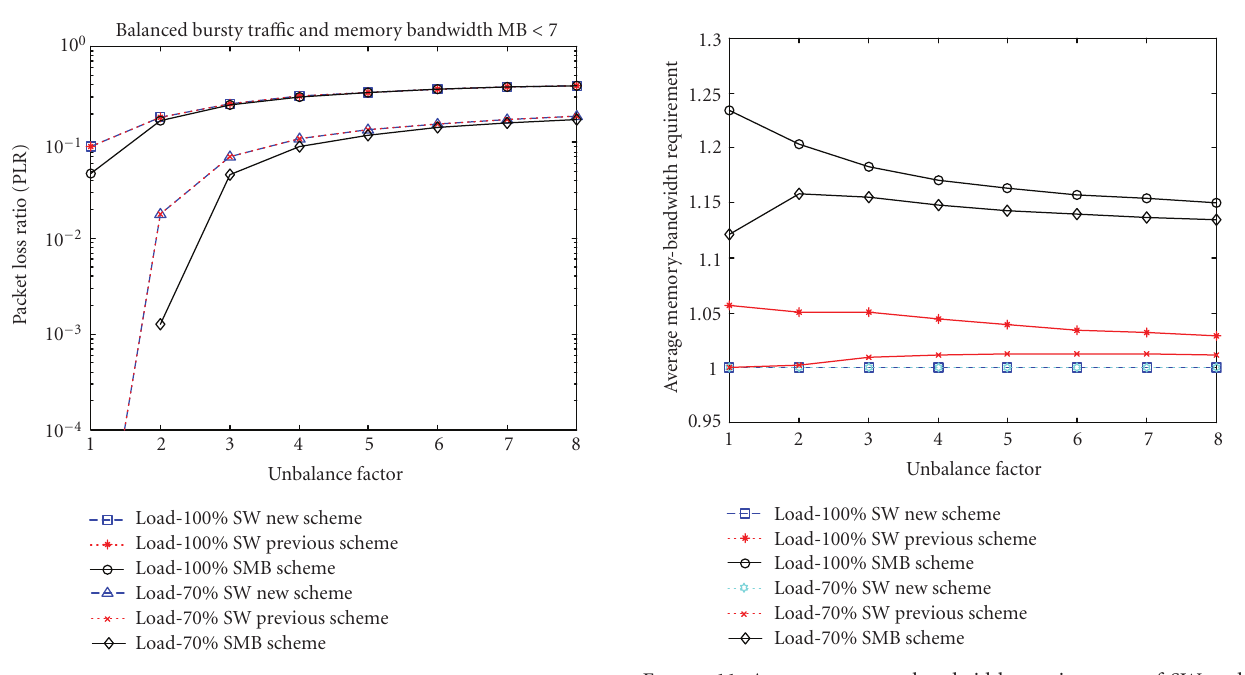
Figure 9: Packet-loss ratio with speed-up of memory modules.